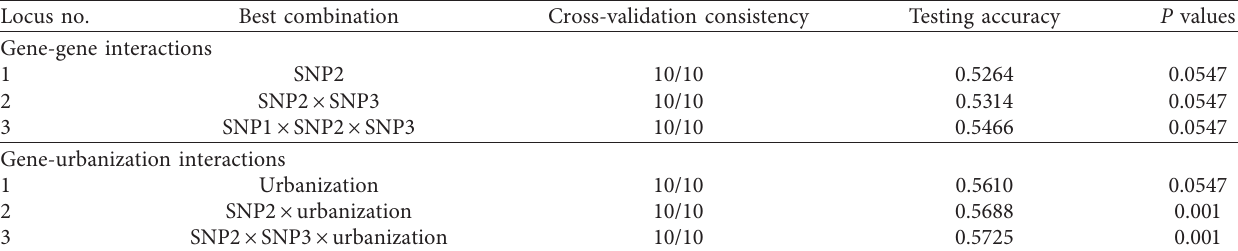
Table 5: GMDR analysis for the best interaction combination models. Locus